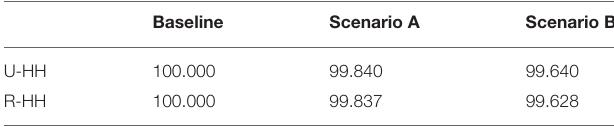
TABLE 2 | Distribution of household income in the fisheries by